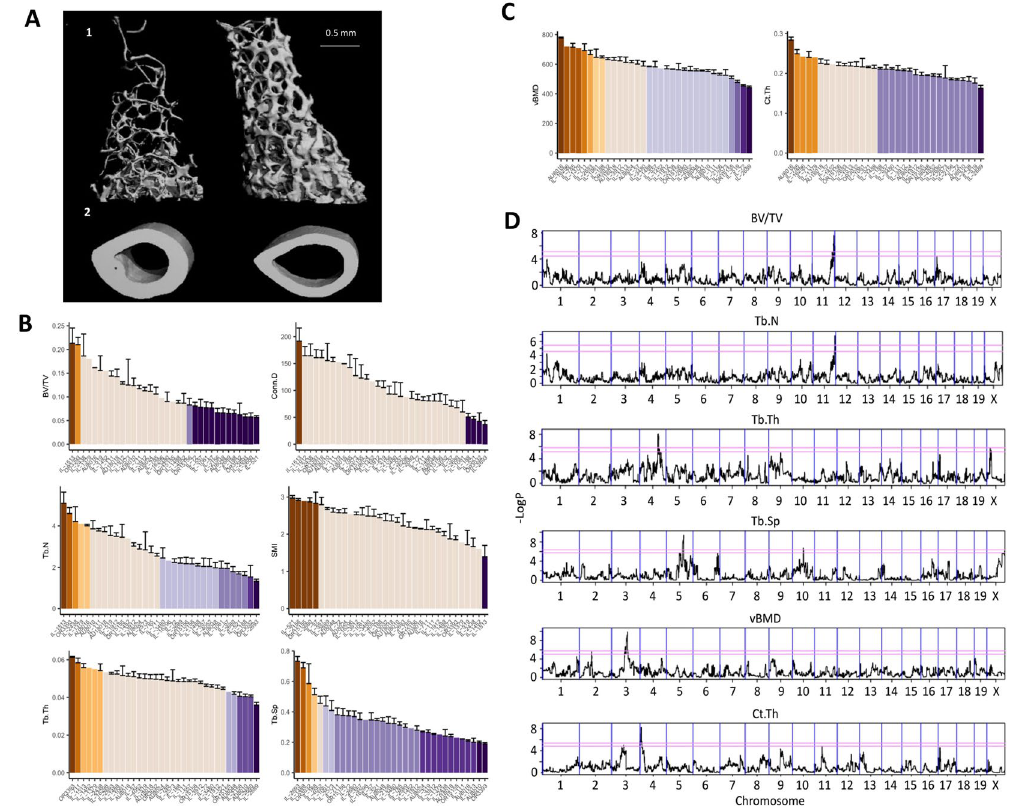
Figure 1. Phenotypic diversity in the CC panel and association test mapping. ( A ) µ CT images of the trabecular (top) and cortical (bottom) bone of the femora of representative male CC mice. Top left: IL-4052; top right: IL-1513; bottom left: IL-785; bottom right: IL-2689. Distribution of trabecular ( B ) and cortical ( C ) traits across the CC lines. The x-axis represents the lines; the y-axis represents the trait means. ( B ) From top left, counter- clockwise: BV/TV (%), Tb.N (mm − 1 ), Tb.Th ( μ m), Conn.D (mm − 3 ), SMI, and Tb.Sp (mm). ( C ) Left, vBMD (mgHA/cm 3 ); right, Ct.Th (mm). Color codes denote group lines that significantly differ from other groups. Lines are ordered differently between traits, in trait-specific descending order. See Table S3 for details. ( D ) Genome-wide association maps for the trabecular and cortical traits. The x-axis represents the position on the chromosome; the y-axis represents the –log P value of the association. The lower threshold represents the 95 th percentile of 200 simulations, and the top one represents the 99 th percentile. The loci above the 99% cut-off were further investigated. From top to bottom: BV/TV, Tb.N, Tb.Th, Tb.Sp, vBMD, and Ct.Th.